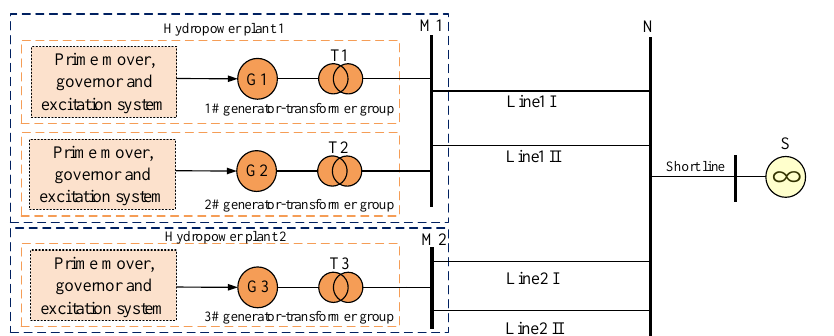
Figure 10. Schematic diagram of the out-of-step fault simulation model system.